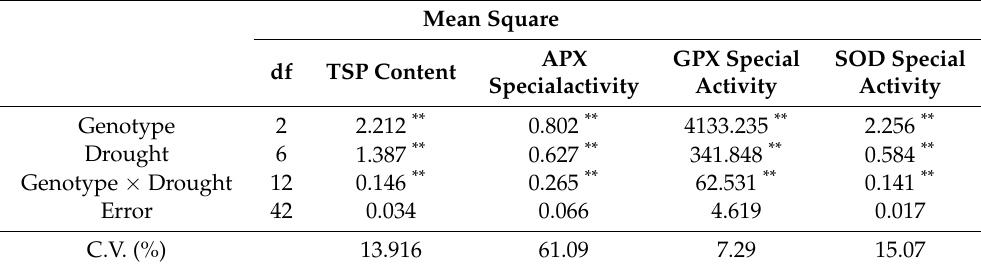
Table 4. The ANOVA for the effects of PEG and sorbitol on the total soluble protein content and the antioxidant enzyme activity of three melon genotypes under in vitro conditions. Mean Square